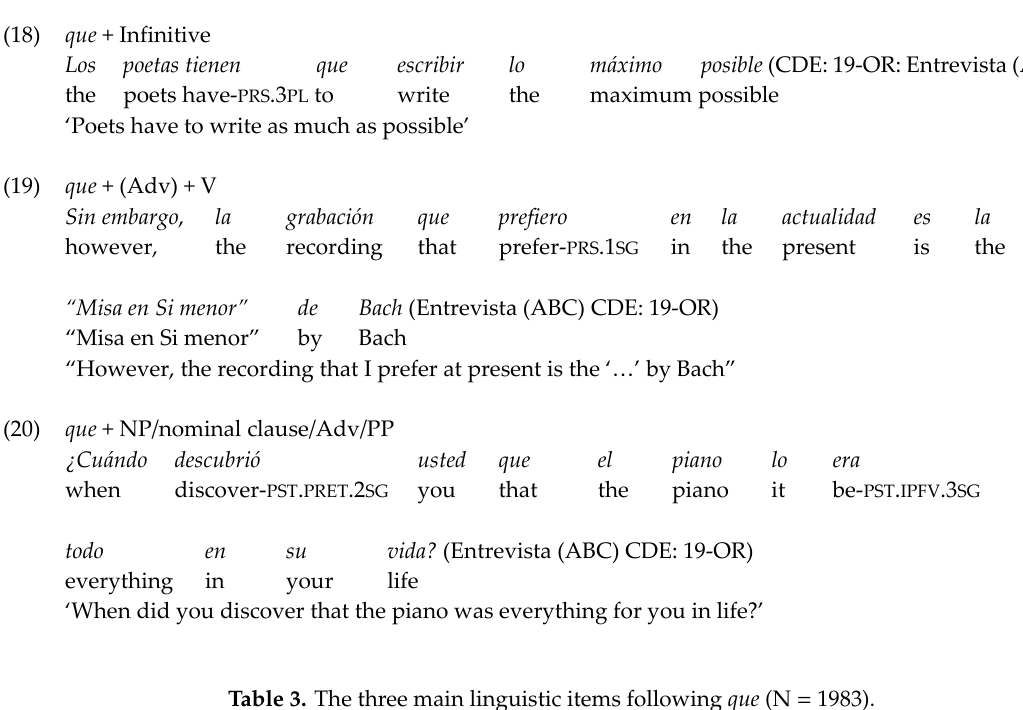
Figure 4. Sub-units of the [ tengo que ] ‘have to’ construction.